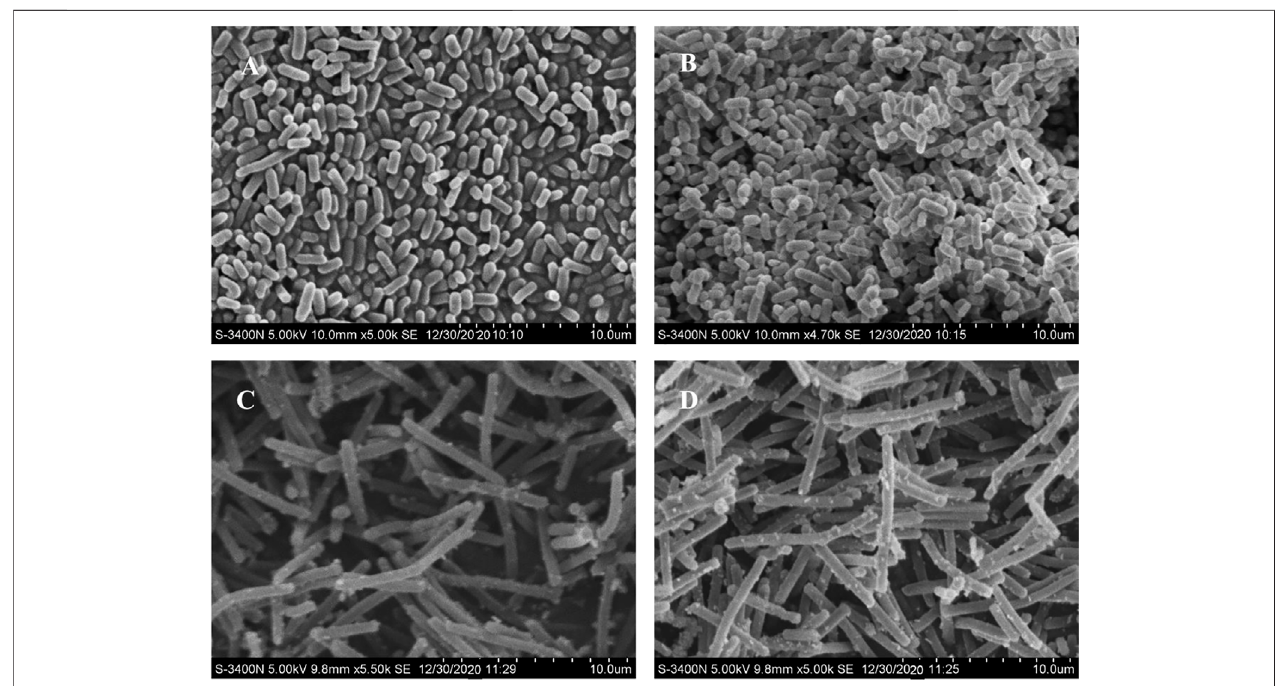
FIGURE 3 | Scanning electron microscopy (SEM) micrographs of free and MRS-based encapsulated L. acidophilus KLDS 1.1003 untreated and treated with Pb (60 mg/L). (A) L. acidophilus KLDS 1.1003 only, (B) MRS-based encapsulated L. acidophilus KLDS 1.1003 only, (C) L. acidophilus KLDS 1.1003 plus lead, (D) MRS- based encapsulated L. acidophilus KLDS 1.1003 plus